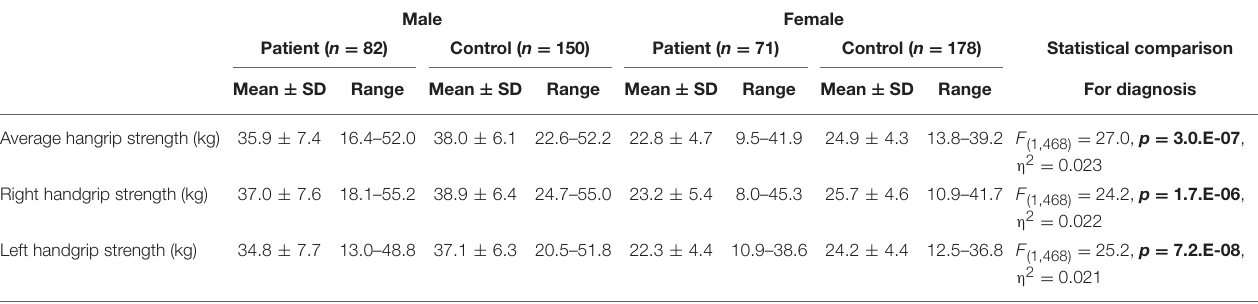
TABLE 2 | Handgrip strength scores of the